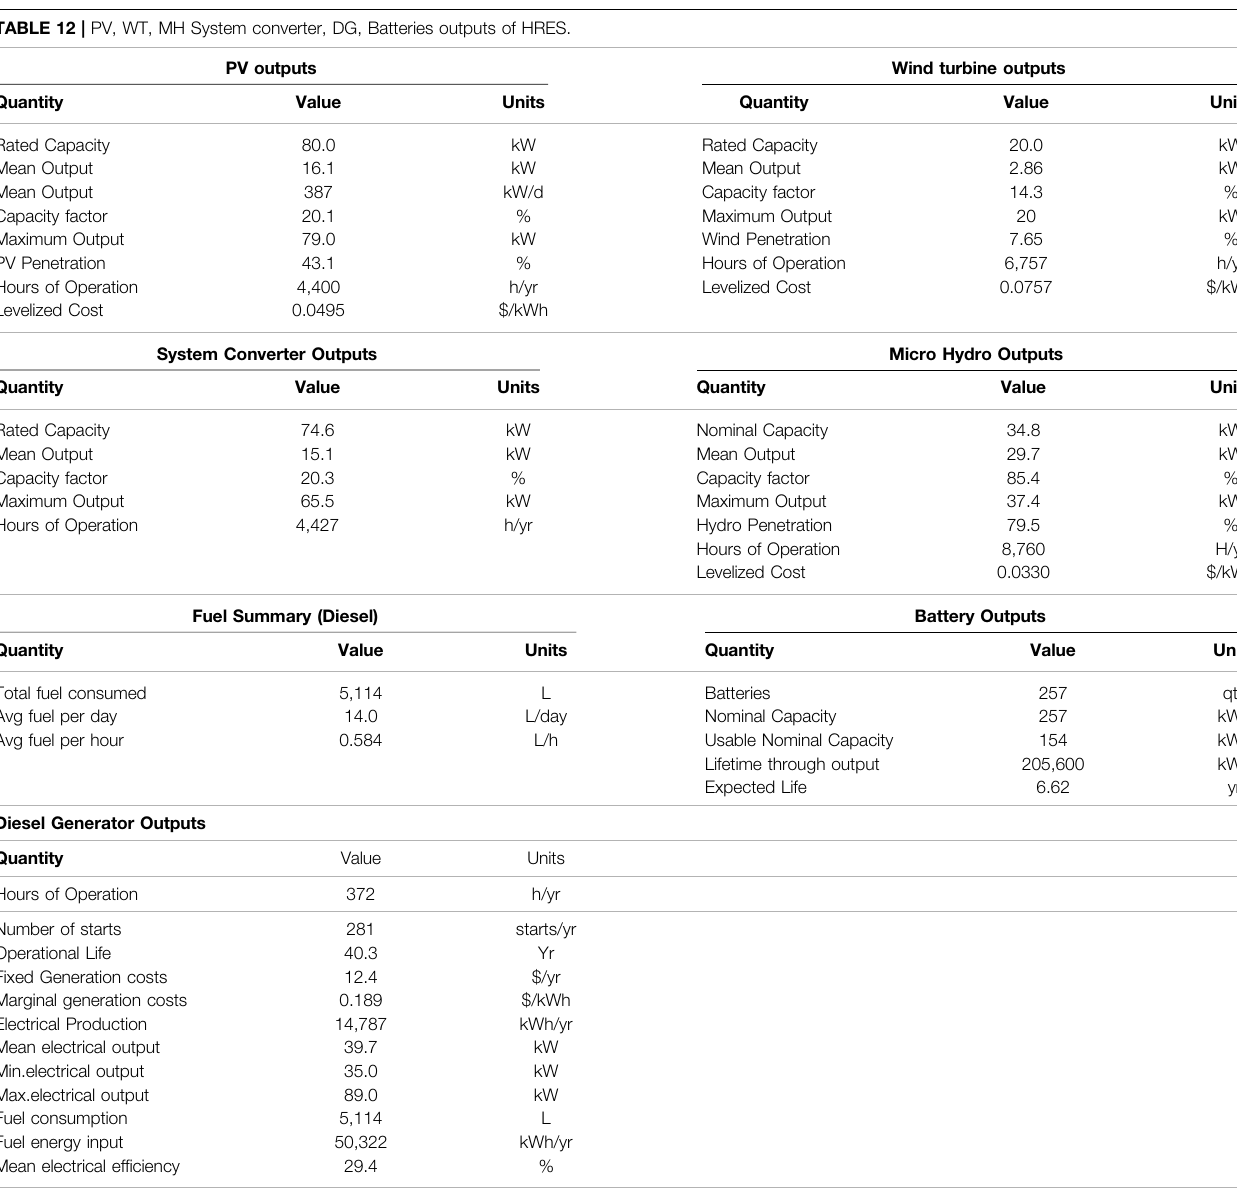
TABLE 12 | PV, WT, MH System converter, DG, Batteries outputs of